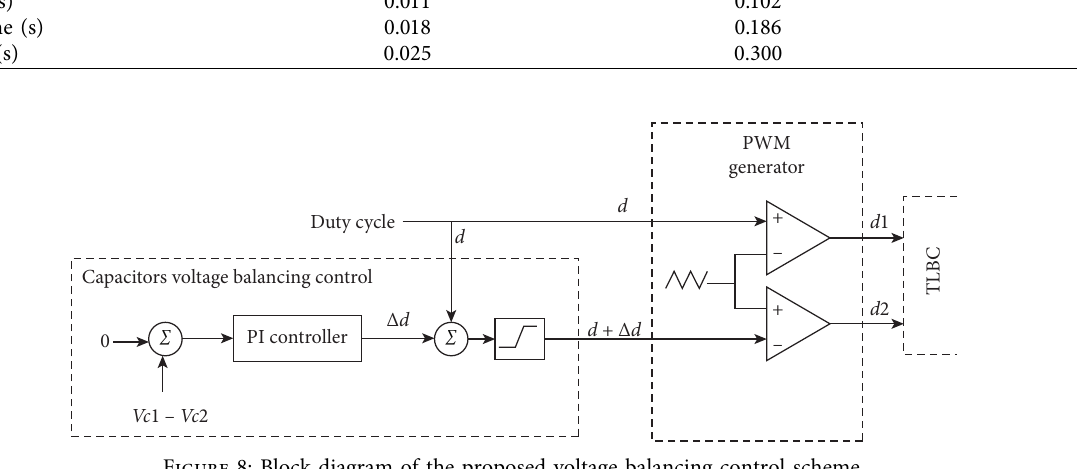
Figure 8: Block diagram of the proposed voltage balancing control